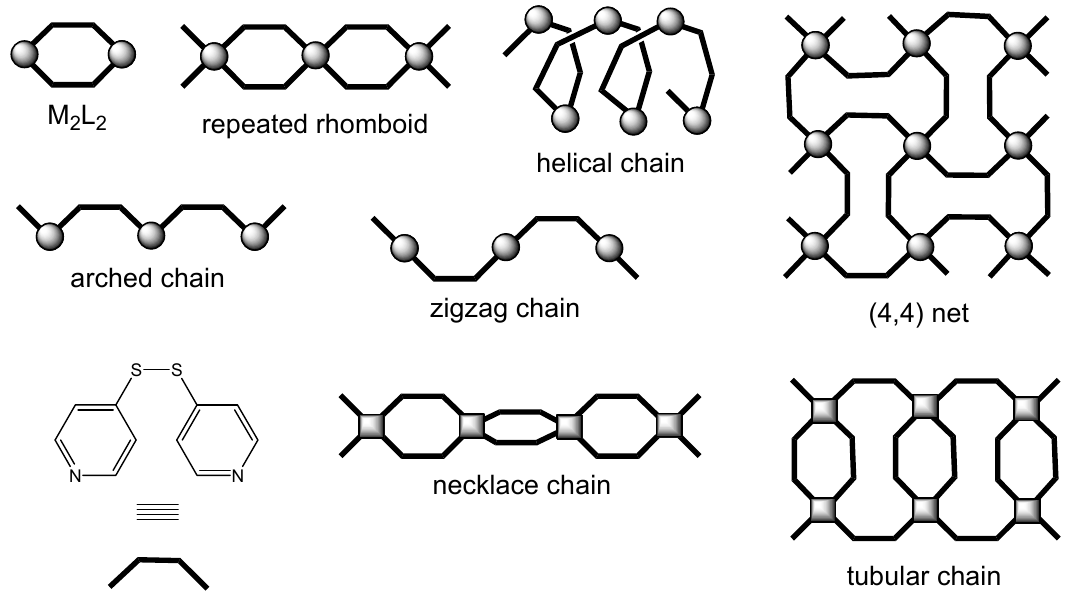
Figure 3. Schematic representation of some basic structural motifs observed for discrete and polymeric metallosupramolecular assemblies containing dtdp and mono- or multinuclear metal units as nodes (respectively illustrated by large grey spheres or